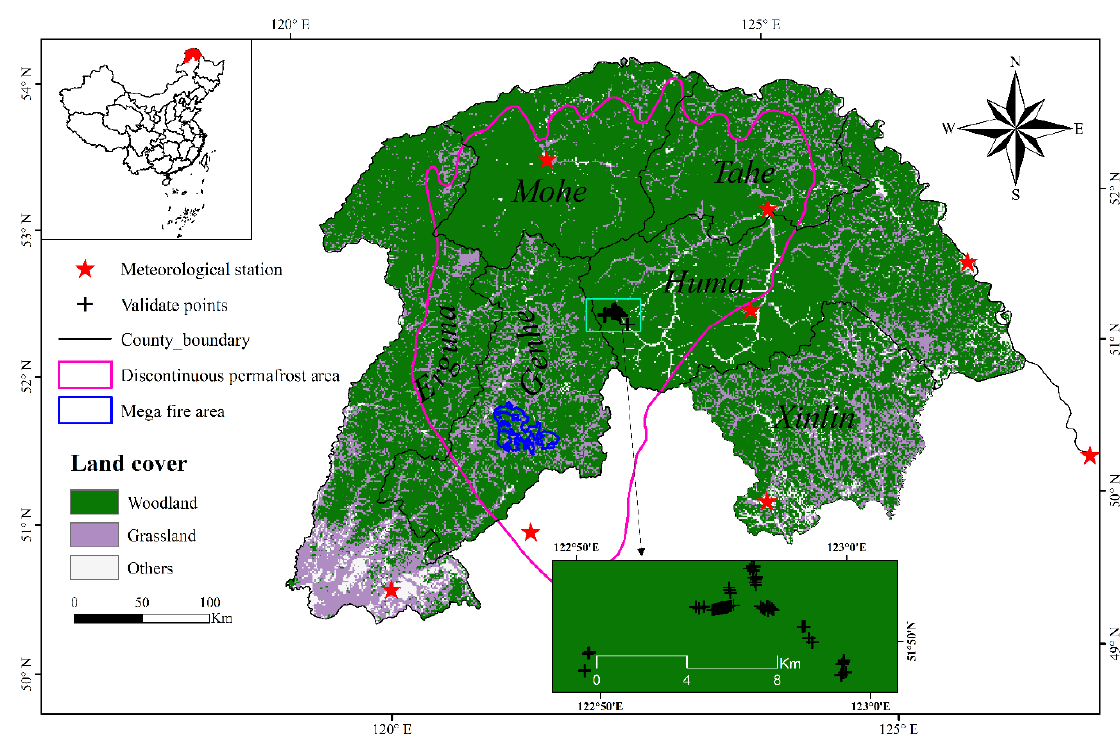
Figure 1. The geographic location of the study area showing county boundaries of the Inner Mongolia Autonomous Region (Erguna and Genhe) and Heilongjiang Province within the study area; the area of discontinuous permafrost; and locations of a mega-fire, validation points, and meteorological stations. An inset map shows the location of the study area within China. The study area is covered by discontinuous (pink area) and sporadic permafrost (outside of pink polygon).